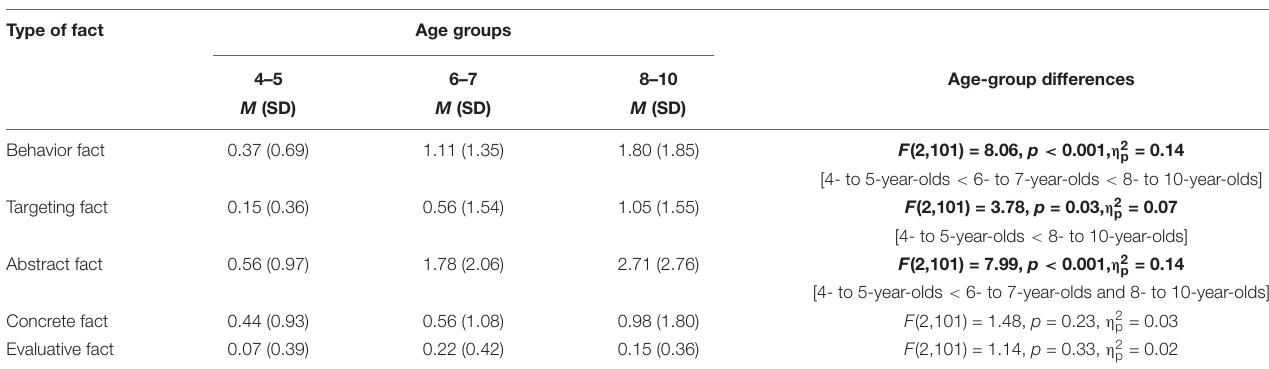
TABLE 7 | Types of recalled facts for experimented-selected